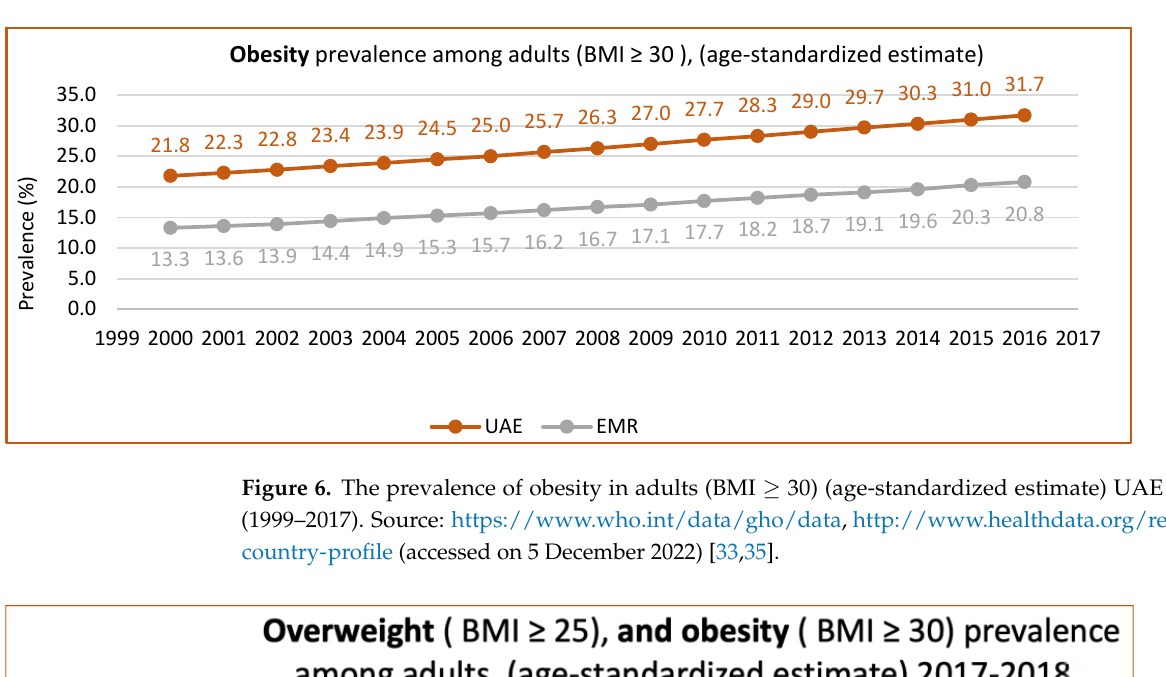
Figure 5. The prevalence of overweight in adults (BMI ≥ 25) (age-standardized estimate), the UAE trend (1999 – 2017). Source: https://www.who.int/data/gho/data, http://www.healthdata.org/re- sults/country-profile (accessed on 5 December 2022) [33,35].